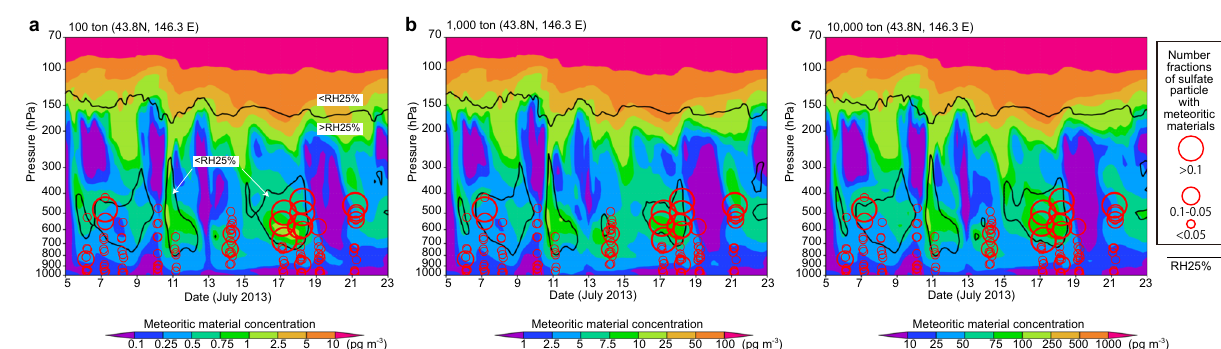
Fig. 7 Simulated vertical distributions of meteoritic materials from the Chelyabinsk meteorite event and observed number fractions of sulfate particles with meteoritic materials. The simulated concentrations (pg m − 3 , colored as indicated near the bottom) at the sampling locations and observed number fractions of sulfate particles with meteoritic materials (red circles) at the sampling altitudes are plotted for initial inputs of a simulated meteorite mass of a 100, b 1000, and c 10,000 tons. Black lines indicate a relative humidity (RH) of 25%. During the tropopause-folding events (e.g., on 7, 17, and 18 July), RH values were <25% around the 400 – 700 hPa levels, at which the number fractions of sulfate particles with meteoritic materials were relatively